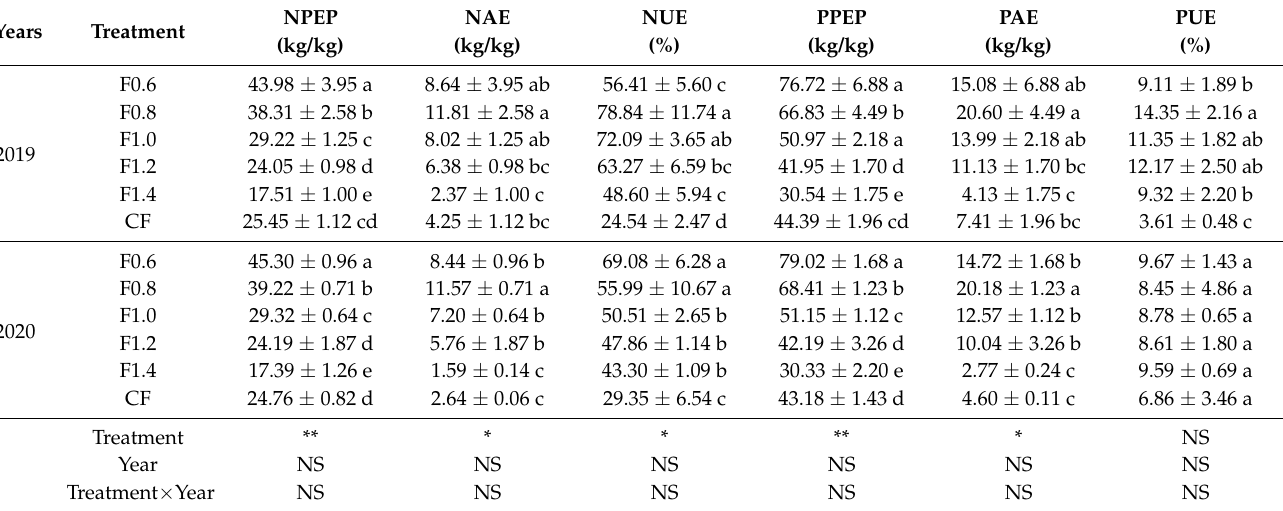
Figure 10. Difference in cotton yield between different fertilization treatments and CK. Note: Values are the means ± standard errors for three biological replicates. Bars with different letters in the same year are significantly different at p < 0.05. Table 5. Effects of different fertilization modes on fertilizer utilization